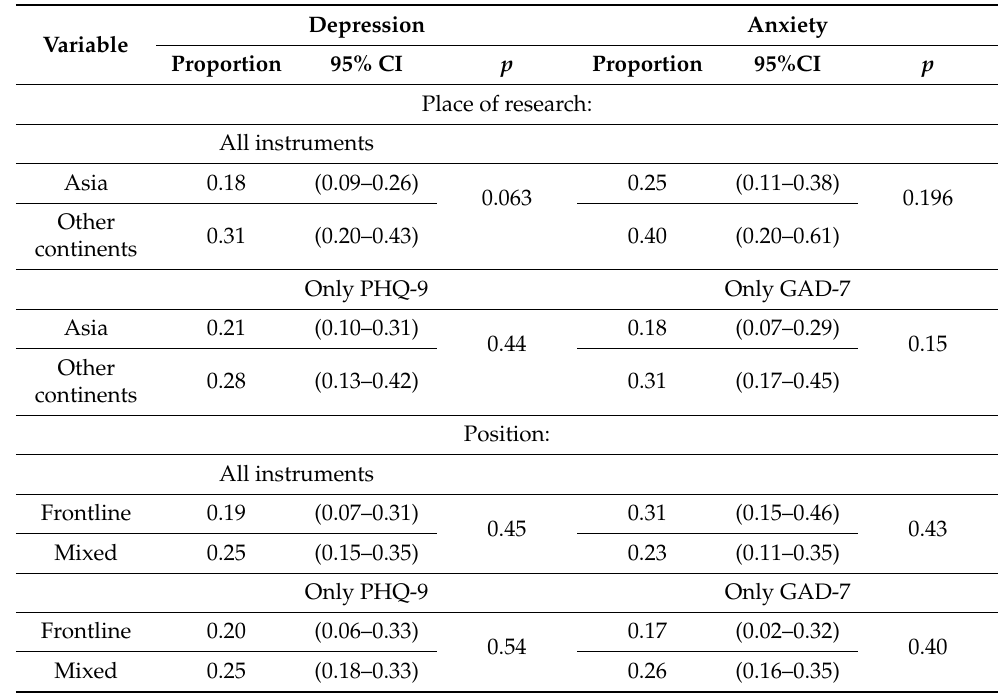
Table 3. Factors related to the incidence of depression and